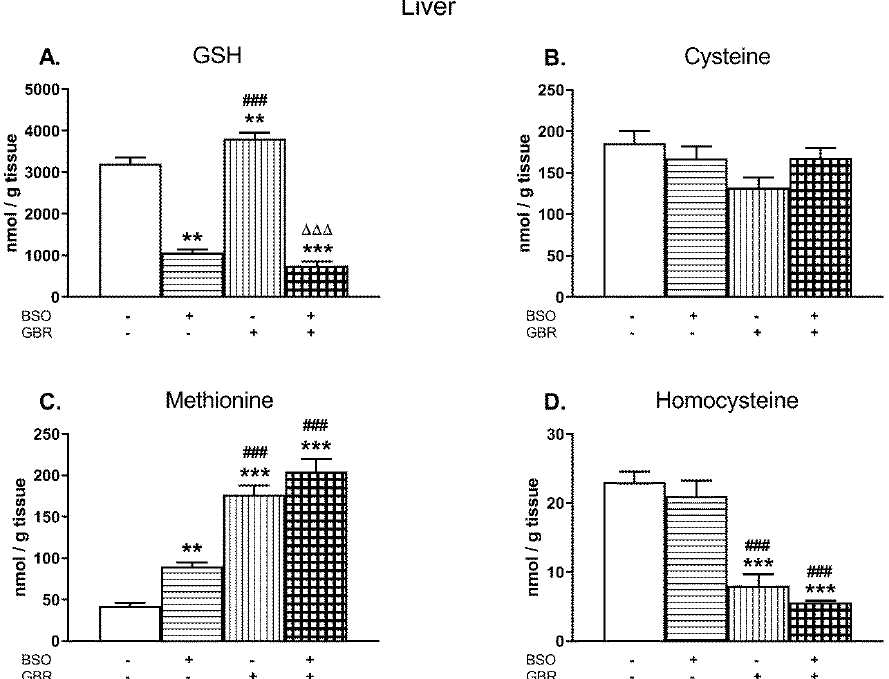
Figure 1. The effects of chronic administration of BSO (3.8 mmol/kg s. c., once daily) and the DAT inhibitor GBR 12,909 (5 mg/kg s. c., every second day), alone or in combination, on the concentrations of GSH ( A ), Cys ( B ), Met ( C ), and Hcy ( D ) in the liver of 16-day-old rats. Data expressed in nmole/g of tissue are presented as the mean ± SEM, n = 7 for each group. Statistical analysis was performed using a two-way ANOVA; symbols indicate significance of differences according to the Newman–Keuls post-hoc test, ** p < 0.01, *** p < 0.001 vs. control; ### p < 0.001 vs. BSO- and ∆∆∆ p < 0.001 vs. GBR 12909-treated groups.